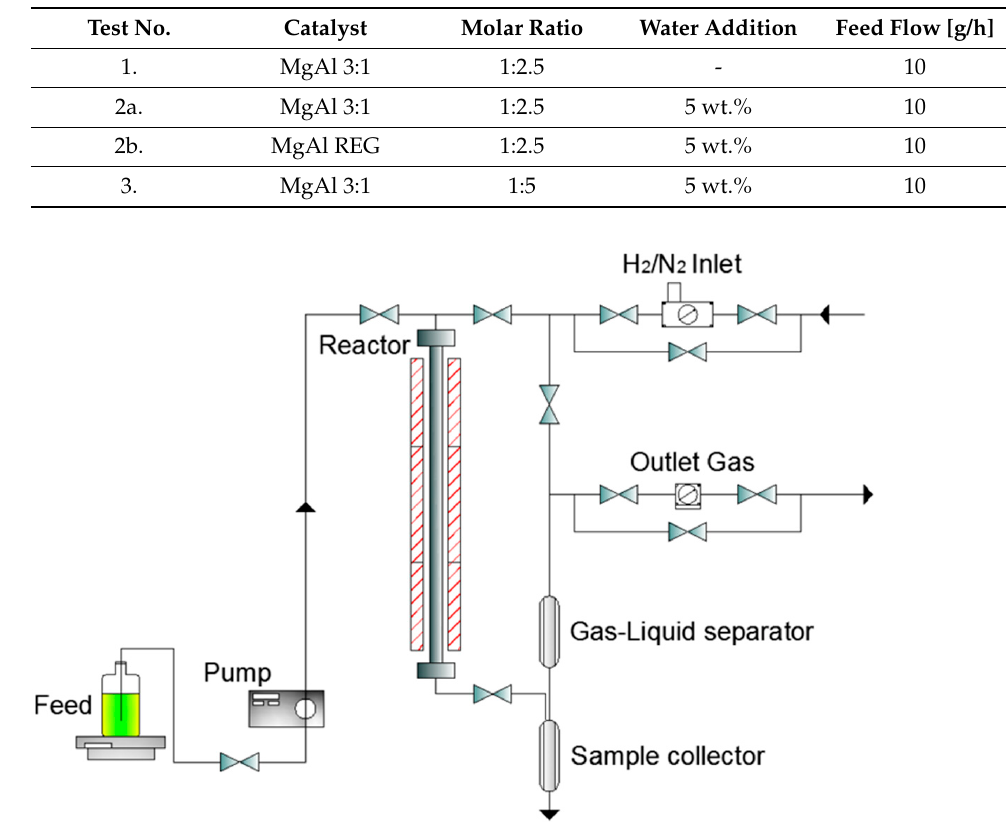
Table 1. The reactions overview of F:Ac experiment in flow-through experiment.